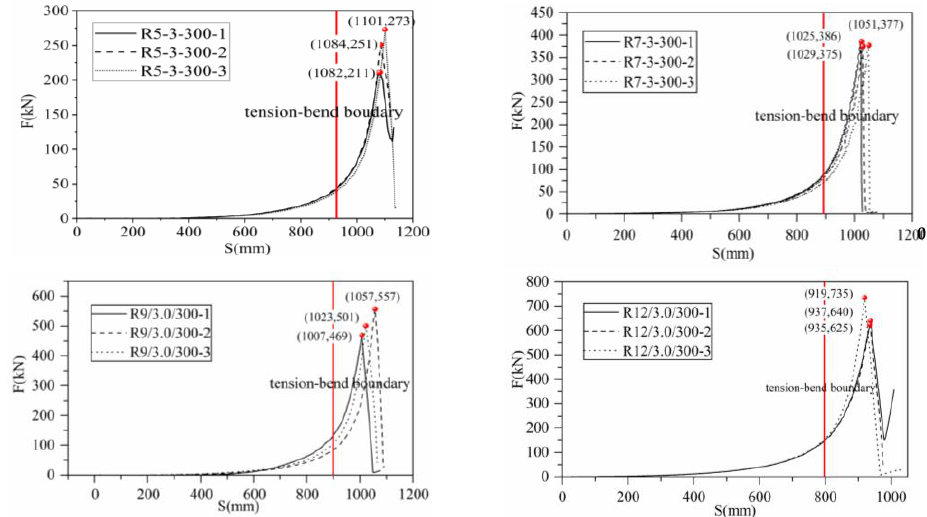
Figure 5. Force displacement curves of the ring net with different specifications.